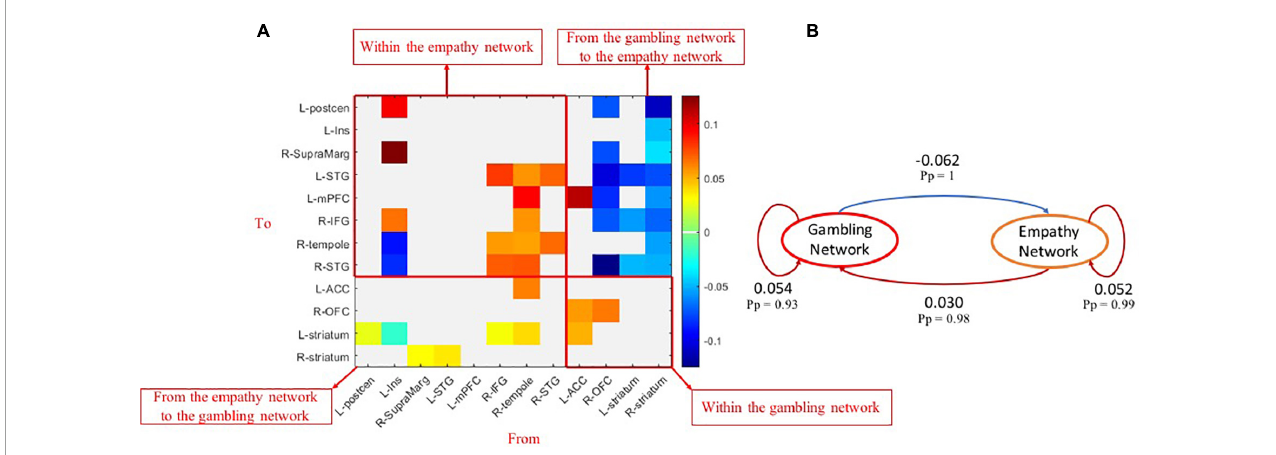
FIGURE3 Group-common effects of effective connectivity among empathy and gambling networks. (A) The causal connections among brain nodes of empathy and gambling networks ( Pp > 0.90); (B) the network-level common causal connections among empathy and gambling networks. Pp , posterior